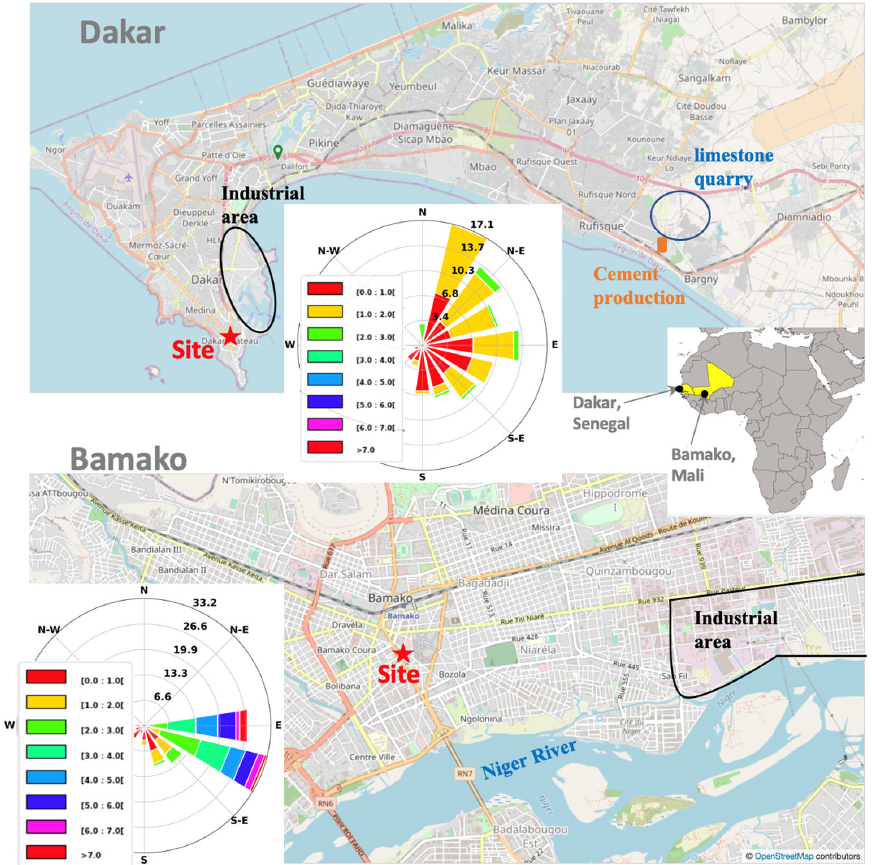
Figure 1. Map of measurement sites with superimposed wind roses during the two field campaigns in Dakar (top) and Bamako (down).